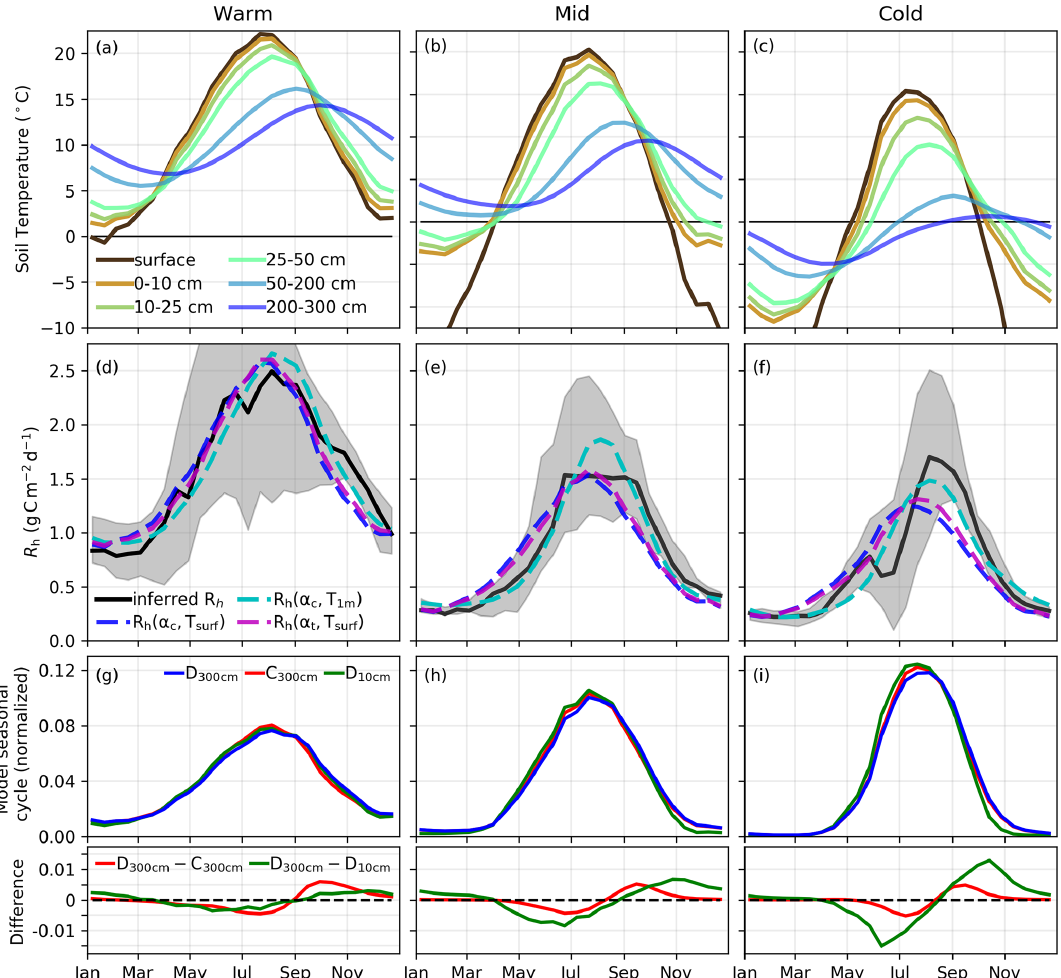
Figure 5. Impact of temporal and vertical variations in carbon pools on R h . (a–c) MERRA-2 Land soil temperature over five intervals for the (a) Warm, (b) Mid, and (c) Cold regions. (d–e) Mean and range in inferred 14d R h with fits for single-layer R h models that employ (navy dash) T surf dependence and no seasonal variations in the carbon pool, (cyan dash) T 1m dependence and no seasonal variations in the carbon pool, and (magenta dash) T surf dependence and seasonal variations in the carbon pool. ( g–i , top) Normalized seasonal cycle of R h simulated by the soil decomposition model (Sect. 2.6). The different lines show different model simulations: D 300cm employs a dynamic carbon pool over 0–300cm depth, C 300cm employs a constant carbon pool over 0–300cm depth, and D 10cm employs a dynamic carbon pool over 0–10cm depth. ( g–i , bottom) Differences in simulated R h between